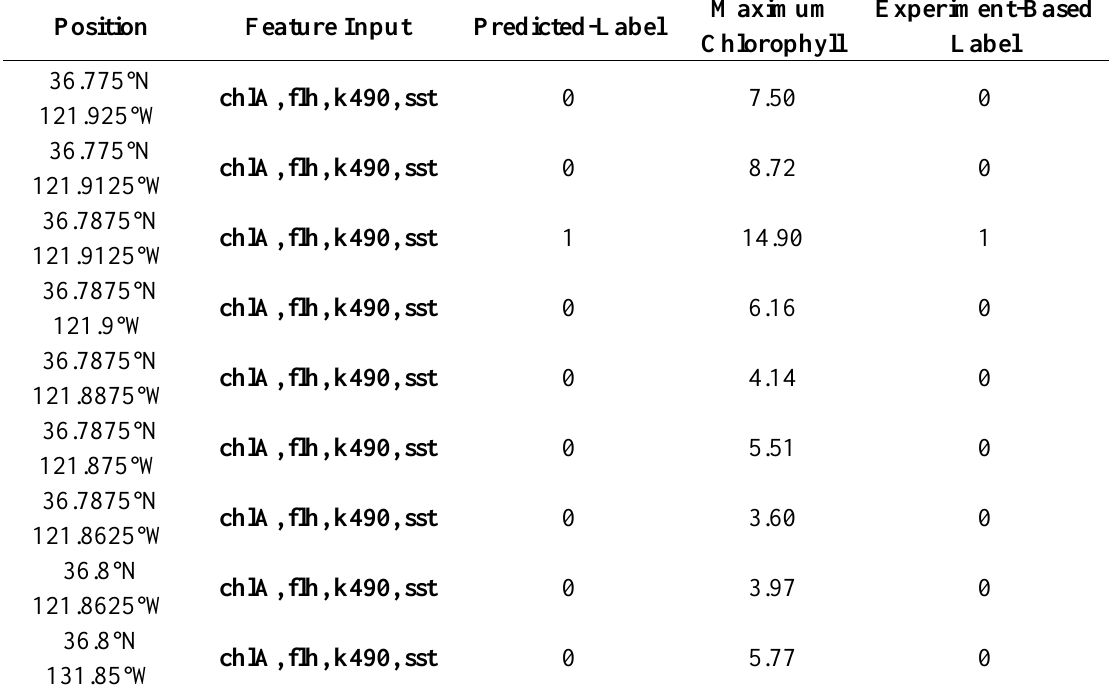
Table 4. Comparison of predicted-label and experiment-based